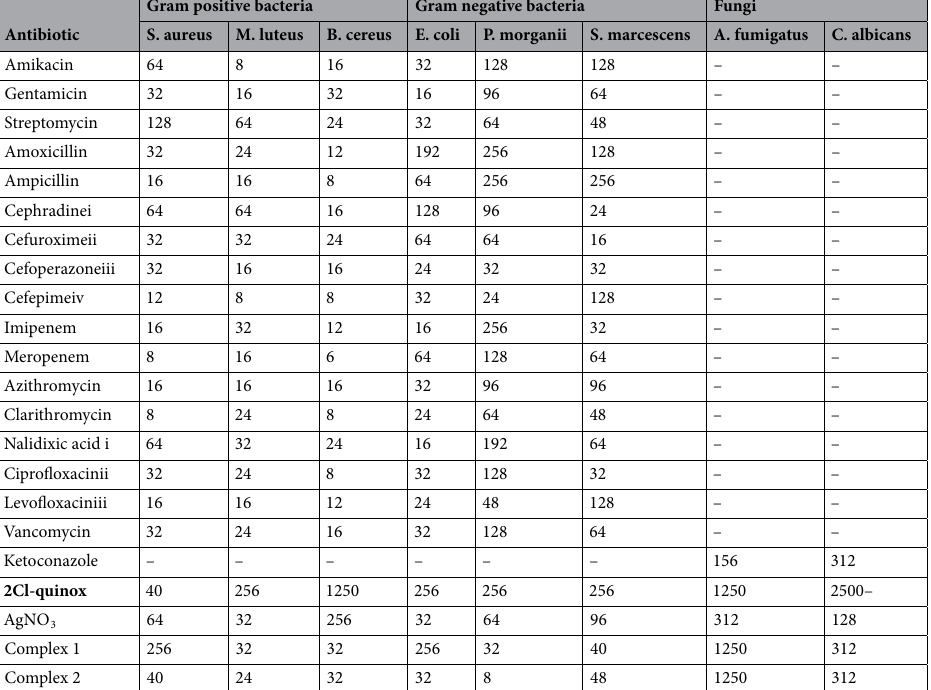
Table 1. Minimum inhibitory concentration (MIC) in µg/mL for complexes 1 and 2 , compared to 2Cl-quinox , AgNO